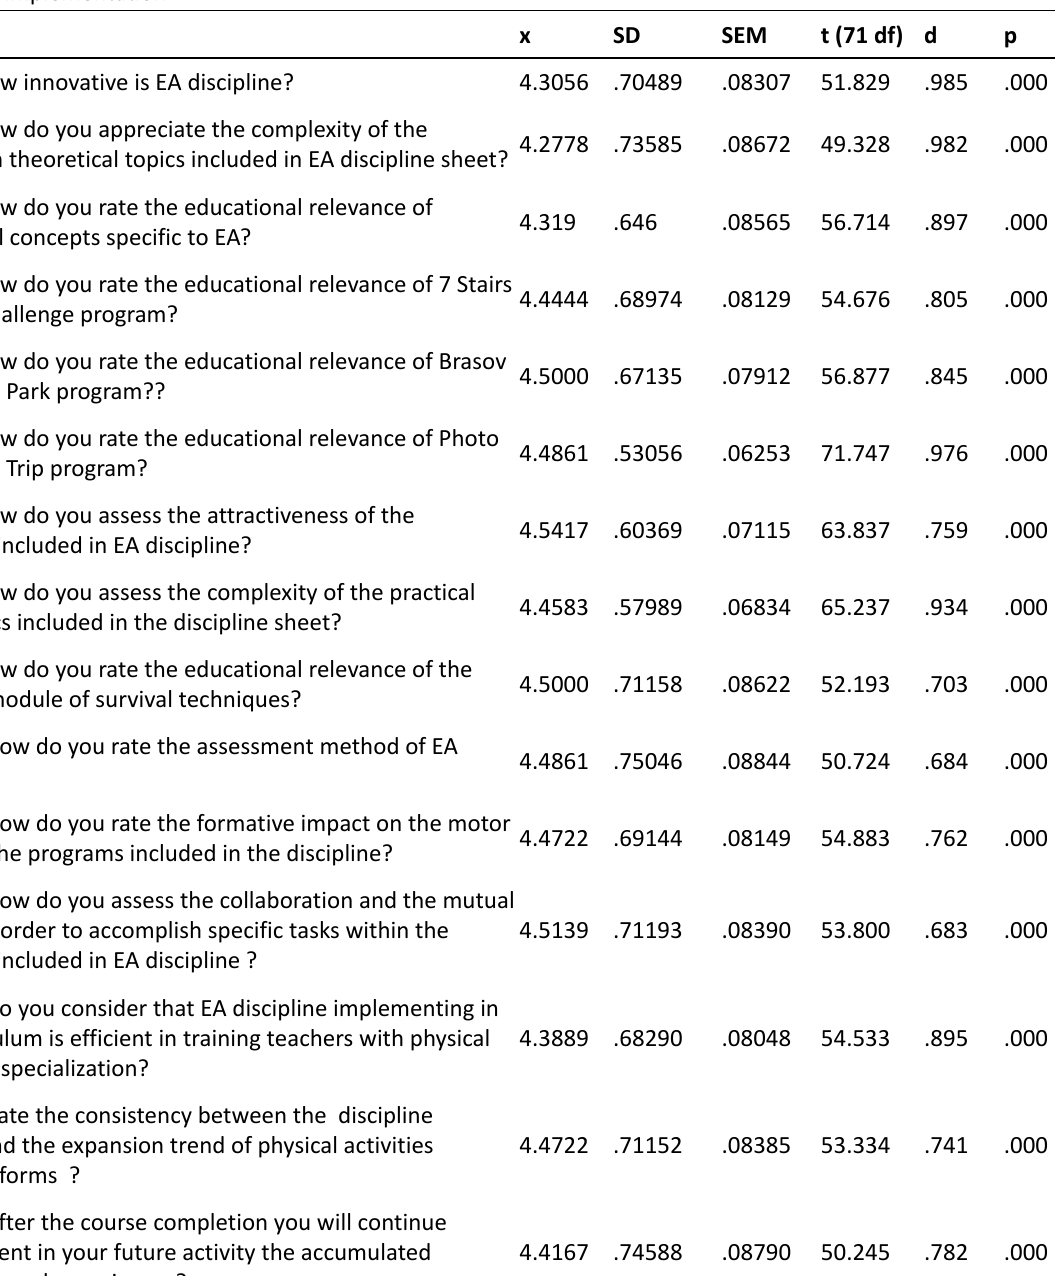
Table 2. Descriptive statistics for the results of the questionnaire assessing the educational impact of the Educational Adventure